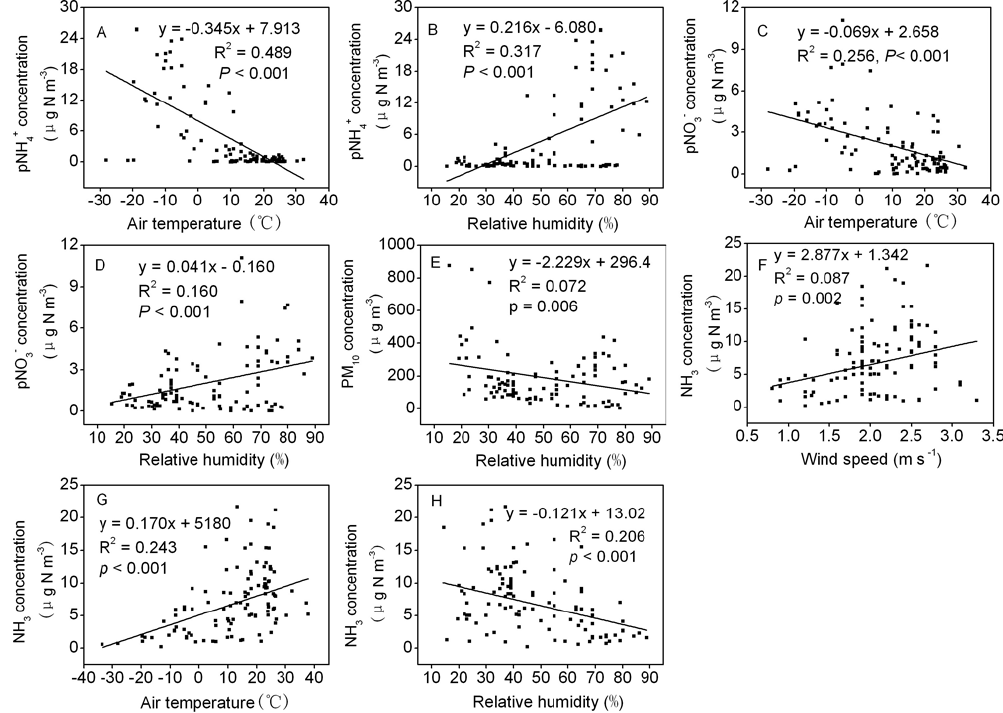
Fig. 6. Correlations among p NH + vs. air temperature; (B) p NH + humidity; (F) NH 3 vs. wind speed; (G) NH 3 vs. air temperature; (H) NH 3 vs. relative